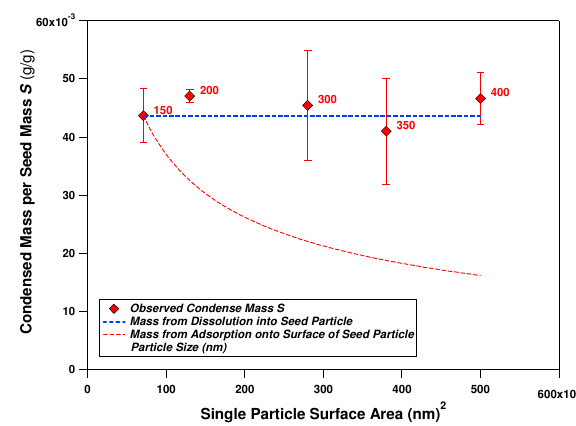
Figure 3. The COM/unit seed particle mass as observed, S , are derived as the slopes of organic mass versus seed particle mass for different particle sizes (e.g., Fig 2). Condensed mass from dissolution in the particle, relative to that at 150 nm seed particle, does not change with particle sizes (heavy dashed line); that from pure adsorption onto particle surface varies inversely with the surface area (light dashed line). The uncertainties in the slopes of COM versus seed particle mass are plotted for each S value.